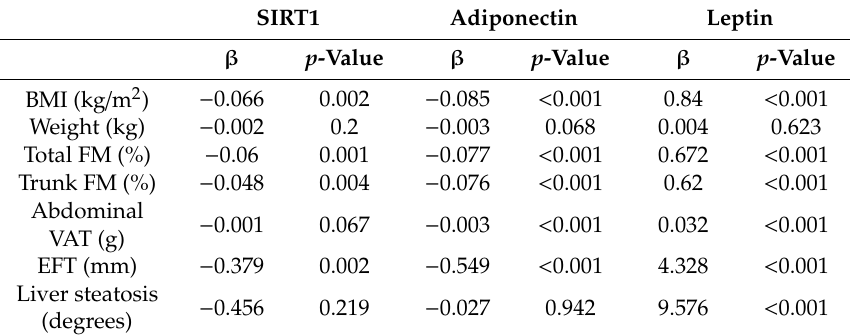
Table 2. Association between fat indicators and SIRT1, adiponectin and leptin adjusted for age and gender.